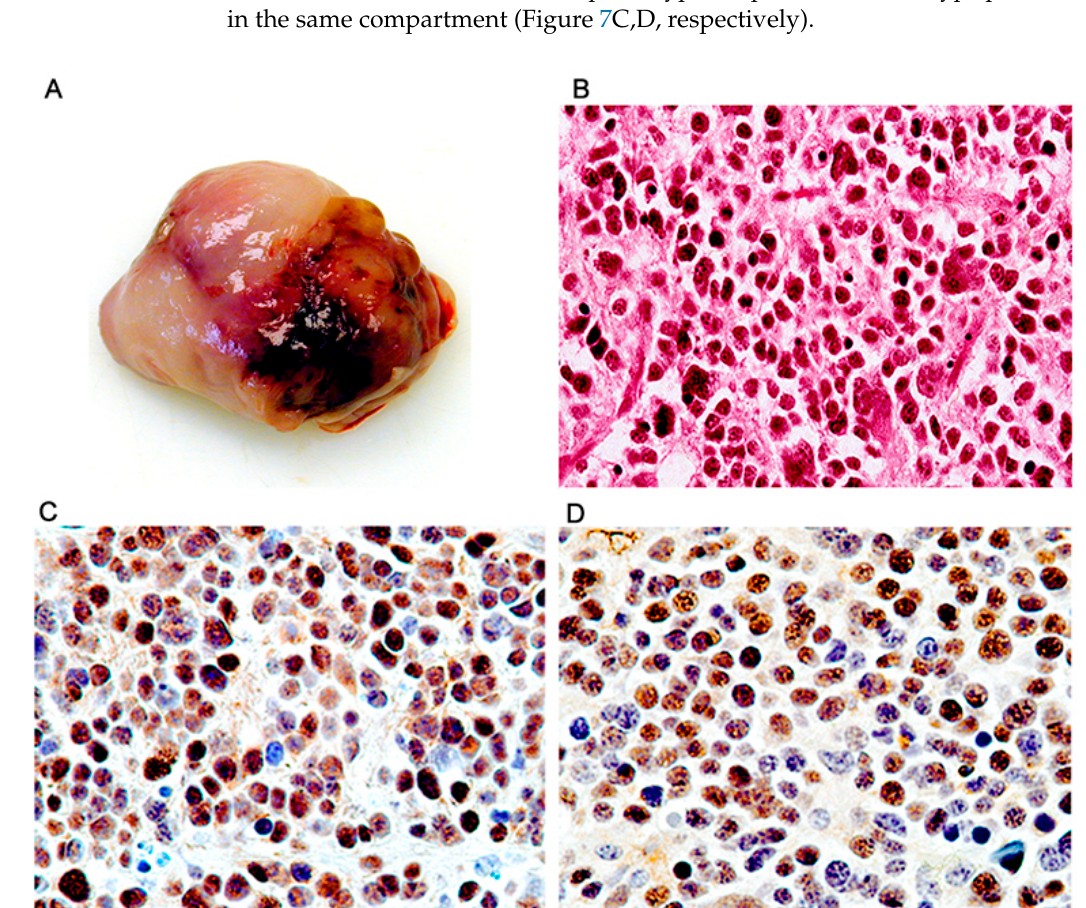
Figure 7. Adrenal neuroblastomas; histological and immunohistochemical characterization. Tumors originated in the adrenal gland and were grossly solid, homogeneous mases (Panel A ). Histologically the tumors were composed of sheets of round cells exhibiting nuclear pleomorphism and scant cytoplasm (Panel B , hematoxylin and eosin). By immunohistochemistry, the majority of neoplastic cells showed robust expression of T ‐ Antigen (Panel C ), and wild ‐ type p53 (Panel D ). (All panels original magnification ×400).